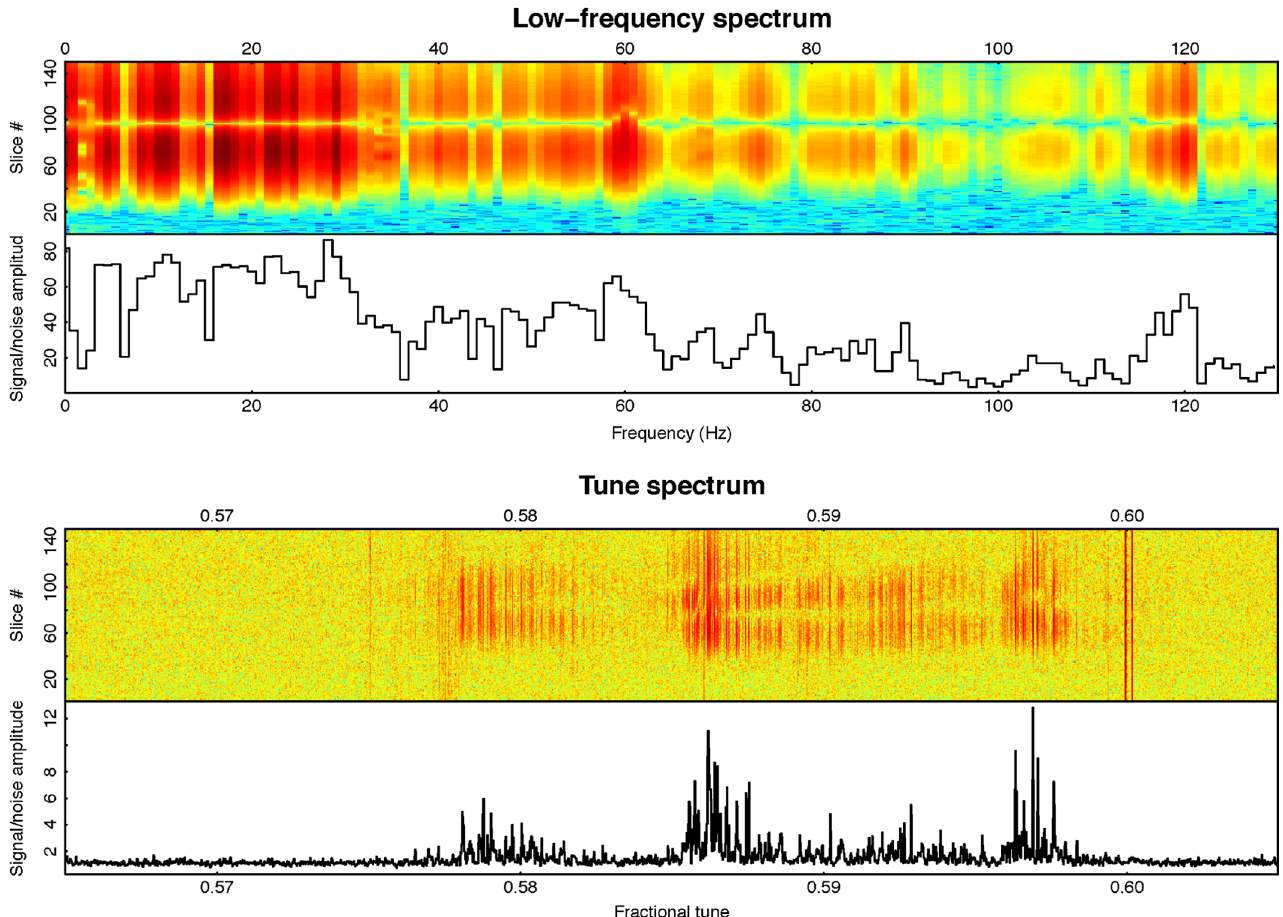
FIG. 5. Example of frequency spectra for antiprotons from data taken during Store 7754. Two selected regions of the spectrum are shown: below 130 Hz (top two plots) and around 47 : 7 kHz (cid:1) ð 1 – 0 : 585 Þ ¼ 20 kHz (bottom two plots). The color plots represent the Fourier amplitude (in logarithmic scale) vs frequency for each slice. The black traces are the average amplitudes of the signal slices divided by those of the background slices (described in the